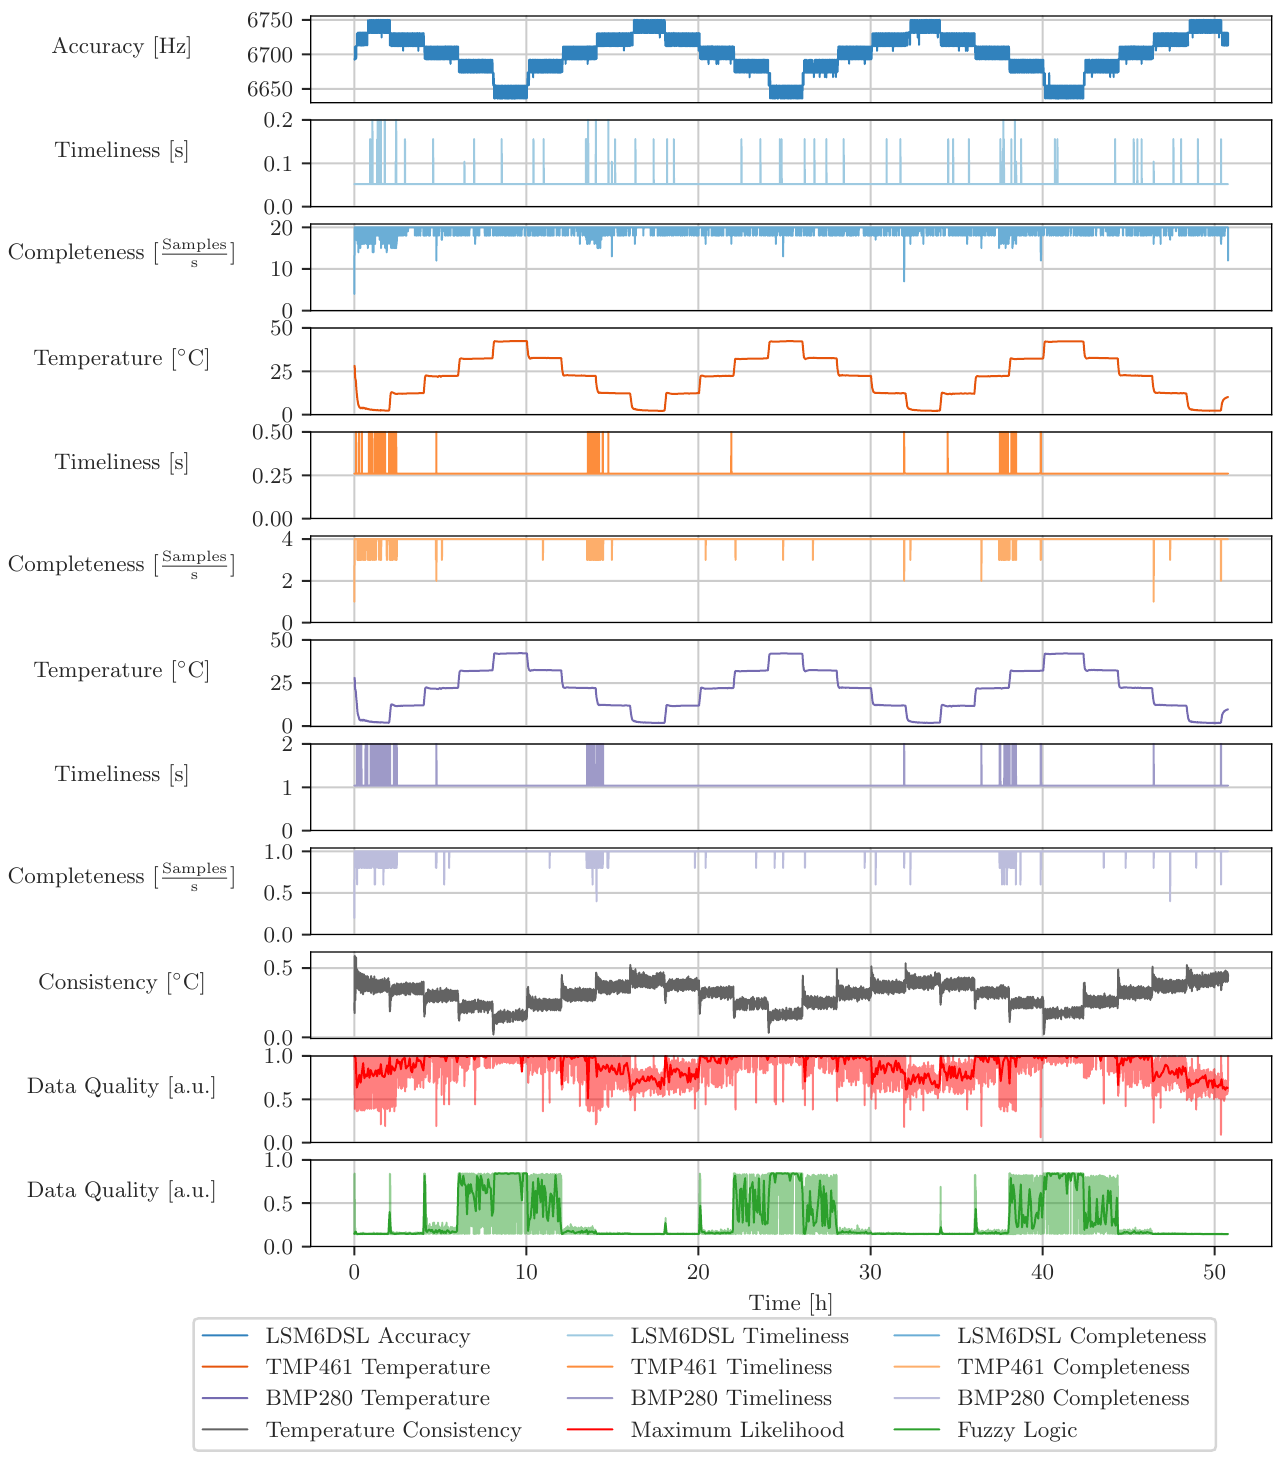
Figure A3. Accelerometer Data Set, sensor system 3, data quality attributes, measured values, and data quality